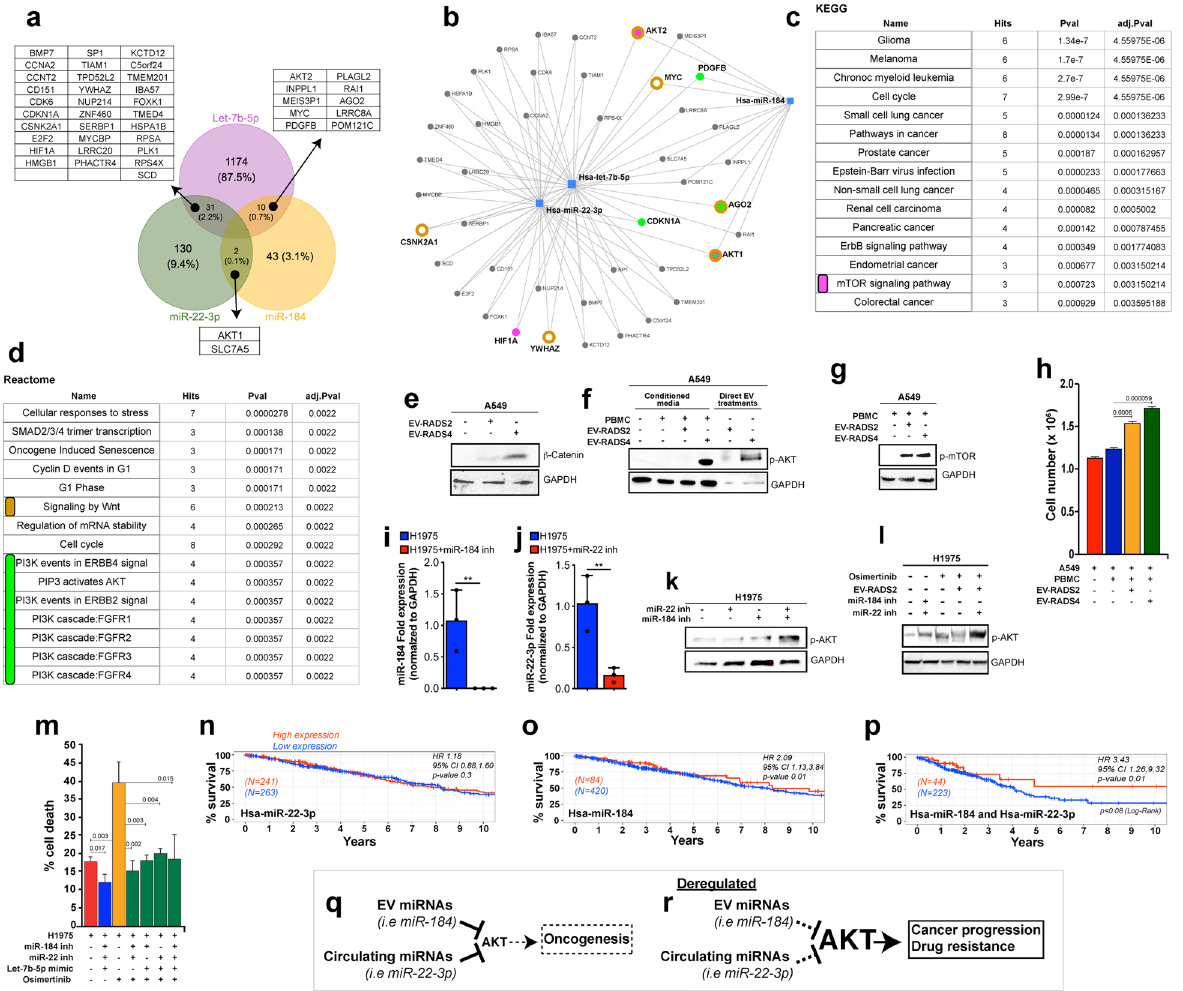
Figure 3. Let-7b-5p, miR-184, and miR-22-3p converge on AKT/mTOR and WNT/β-catenin therapy resistance pathways. ( a ) Venn diagram showing the number unique of shared protein targets between the selected miRNAs. ( b ) MIRNET star-network showing proteins that are targeted by at least two of the three miRNAs (blue squares). ( c , d ) KEGG ( c ) or Reactome ( d ) classification analyses of the identified proteins show a convergence onto PI3K-AKT-mTOR ( c , magenta label and d green label) and WNT/β-catenin ( d , brown label) signaling pathways. The underlying target genes are shown in corresponding color in “ b ”. ( e ) Western blot image from A549 cells treated with equal quantity of EV from cancer patients or from high-risk screening controls. Blots were stained against β-catenin to detect WNT signaling levels or GAPDH as a loading control. ( f , g ) Western blot images from A549 cells cultured in standard media or media conditioned with PBMC in the absence or presence of patients EV ( f , lanes 1–4). Also, A549 cells were treated directly with cancer patients or control EV ( f , lanes 5 and 6). Blots were stained against phospho-AKT1 ( f ) or phospho-mTOR ( g ) or GAPDH as a loading control ( f , g ). A549 cell numbers from supernatant transfer experiments ( f , lanes 1–4) are shown in “ h ” as average cell numbers from triplicate experiments. Error bars denote SD values. P values are derived from student t-test analyses. ( i , j ) qPCR data showing mean expression fold changes of miR-184 ( i ) or miR-22-3p ( j ) in H1975 cells transfected with miR-184 ( i ) or miR-22-3p inhibitors ( j ) (blue bars) compared to untreated H1975 control cells (red bars). Expression was normalized to GAPDH. ( k ) Western blot images from H1975 cells left untreated or treated with miR-22-3p or miR-184 inhibitors and blotted against phospho-AKT1 or GAPDH (loading control). ( l ) Image of a Western blot from untreated H1975 cells or H1975 cells treated with equal portions of EV from screening controls (RADS-II) or with inhibitors against miR-22-3p and/or miR-184 inhibitors followed with Osimertinib (100 nM) treatments. Western blots were stained against phospho-AKT or GAPDH (loading control). ( m ) Graph showing the proportion of H1975 cell death across the indicated conditions using Trypan blue exclusion assays. These cell death assays were performed in triplicates and the results are shown as the average proportion (percentage) of dead cell across replicates for each treatment conditions. Error bars denote standard deviations and p values were derived from t-tests. ( n – p ) Survivorship comparison data using miR-184 and/ or miR-22-3p expression data in TCGA-LUAD and the Bioconductor tool TCGA Biolinks RTCGA R packages. The “surv_cutpoint” function of the “survminer” R package was used to identify high versus low expressing patients’ samples for miR-22-3p ( n ) or miR-184 ( o ) or both ( p ) in Cox regression analyses. Survminer uses selected rank statistics to determine the optimal cut-point of a continuous variable in an unbiased manner. The related bioinformatics and statistics are presented in Supplementary Information 1. ( q , r ) proposed model summarizing the role of mir-184/mir-22 in Osimertinib drug response. EV (mir-184) and circulating (mir-22) plasma miRNAs cooperatively target and modulate AKT activity. ( q ) Cancer-free high-risk individuals up-regulate EV mir-184 and circulating mir-22, keeping AKT levels generally low. In the context of genetic driver mutations, this low AKT activity delays oncogenesis. Similarly, cancer patients with high EV mir-184 and circulating mir-22-3p maintain AKT below an activity threshold required for AKT-mediated drug resistance, leading to positive drug response. However, AKT baseline activity is elevated in patients with low mir-184/mir-22 levels such that even a modest stimulation of AKT drives AKT above the drug-resistance activity threshold, leading to relapses and poor clinical response ( r